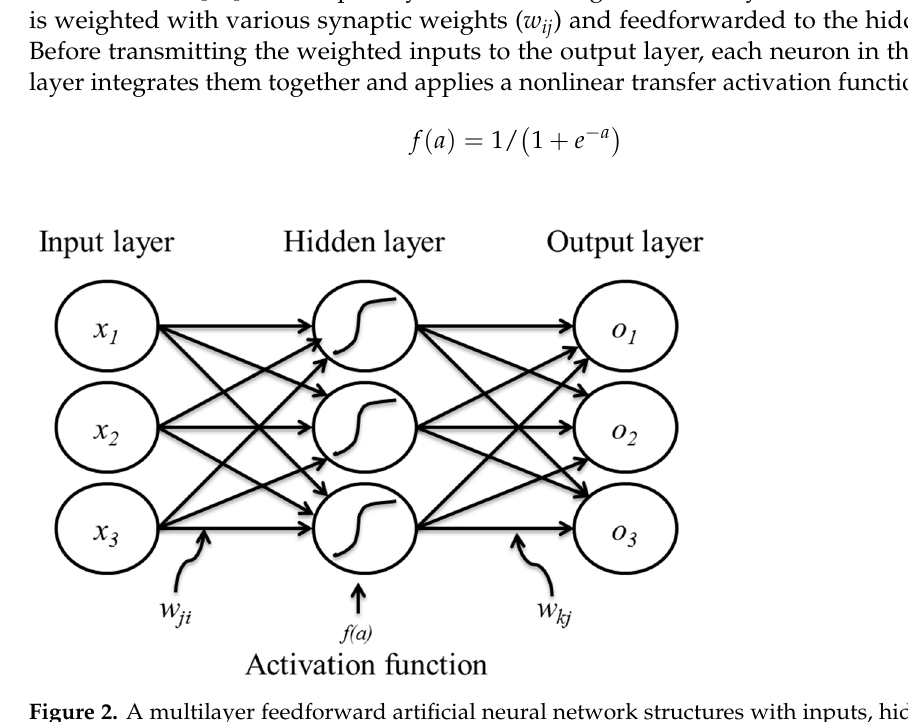
Figure 2. A multilayer feedforward artificial neural network structures with inputs, hidden layer, and outputs.